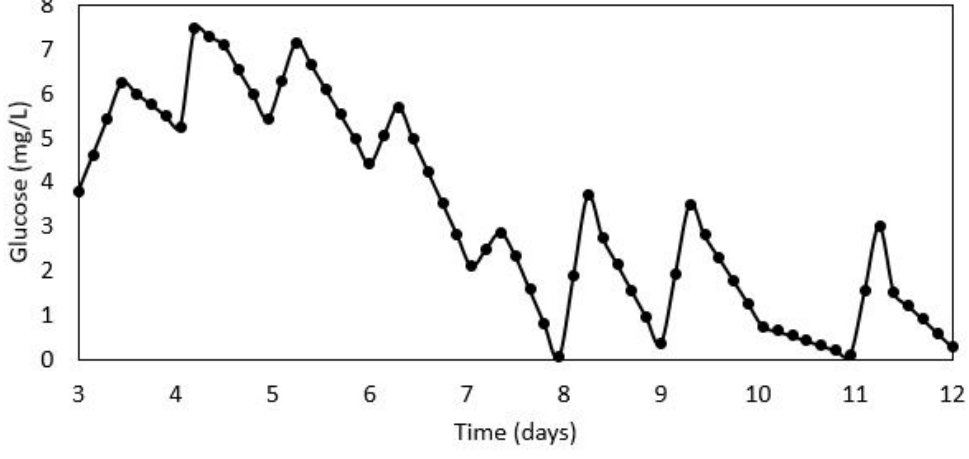
Figure 1. The glucose input profiles for a training batch using the incorrect assumption of taking measurements whenever they are